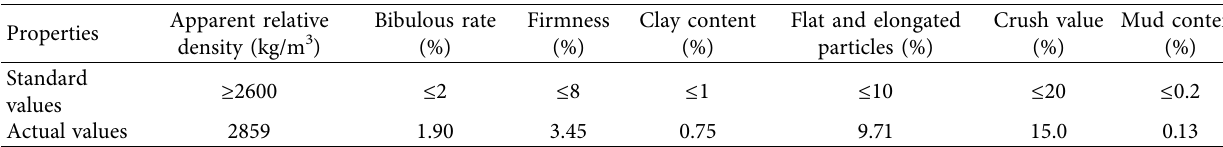
Table 4: Basalt gravel performance index